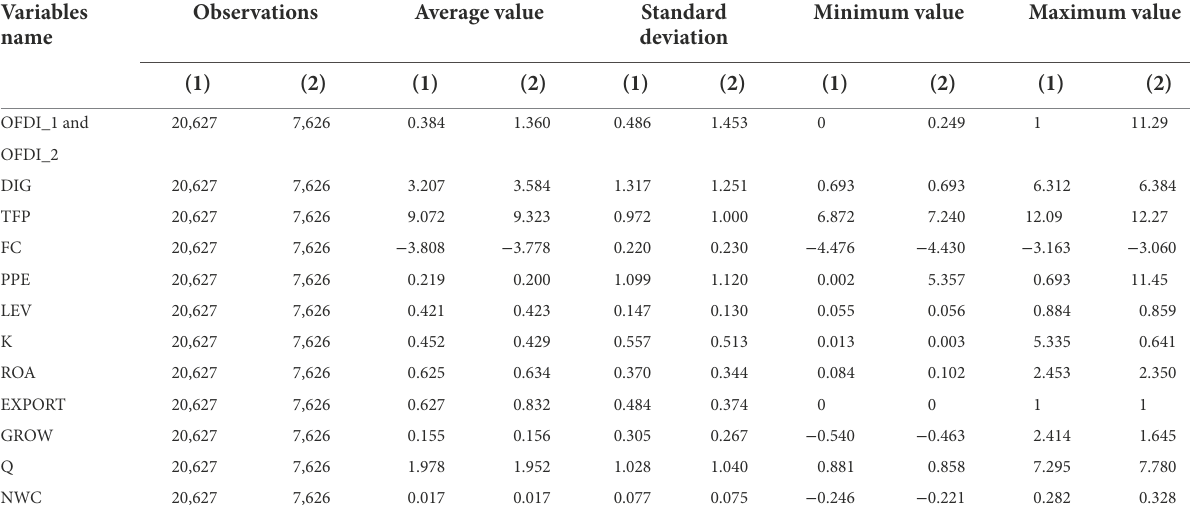
TABLE 3 Results of descriptive statistics of main variables.